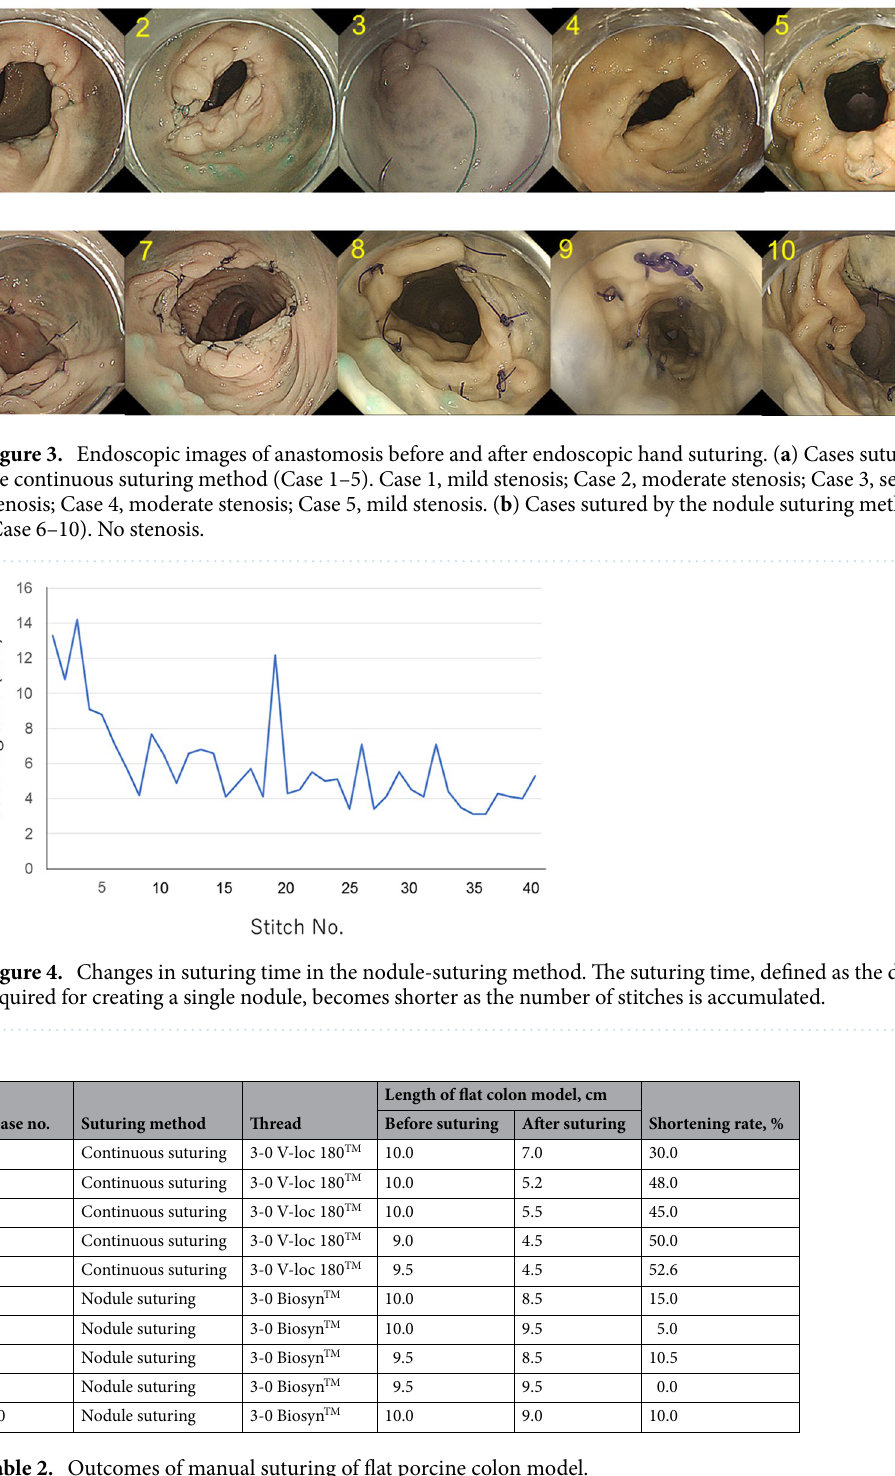
Table 2. Outcomes of manual suturing of flat porcine colon